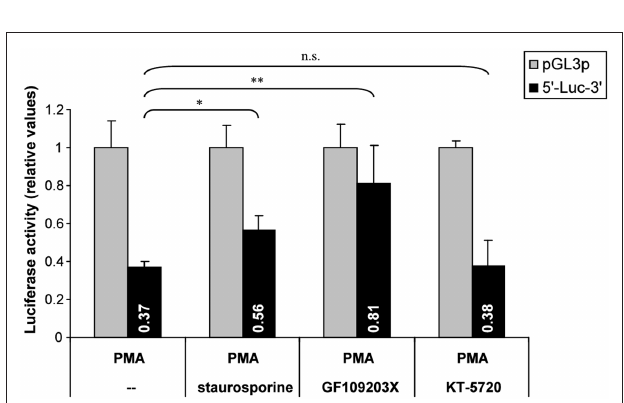
Figure 7 | influence of PKC inhibition on PMA-mediated post-transcriptional control of hASH1 mrNA. Kelly cells were transfected with a reporter vector containing the hASH1 mRNA 5 ′ - and 3 ′ UTRs as regulatory elements that determine the reporter gene expression rate. Following 24 h of transfection, cells were pre-incubated either with solvent (--), the PKC inhibitors staurosporine or GF109203X, or with the PKA inhibitor KT-5720 for 4 h and subsequent administration of PMA (24 h). n = 6; * p < 0.05, ** p < 0.01; ns, not